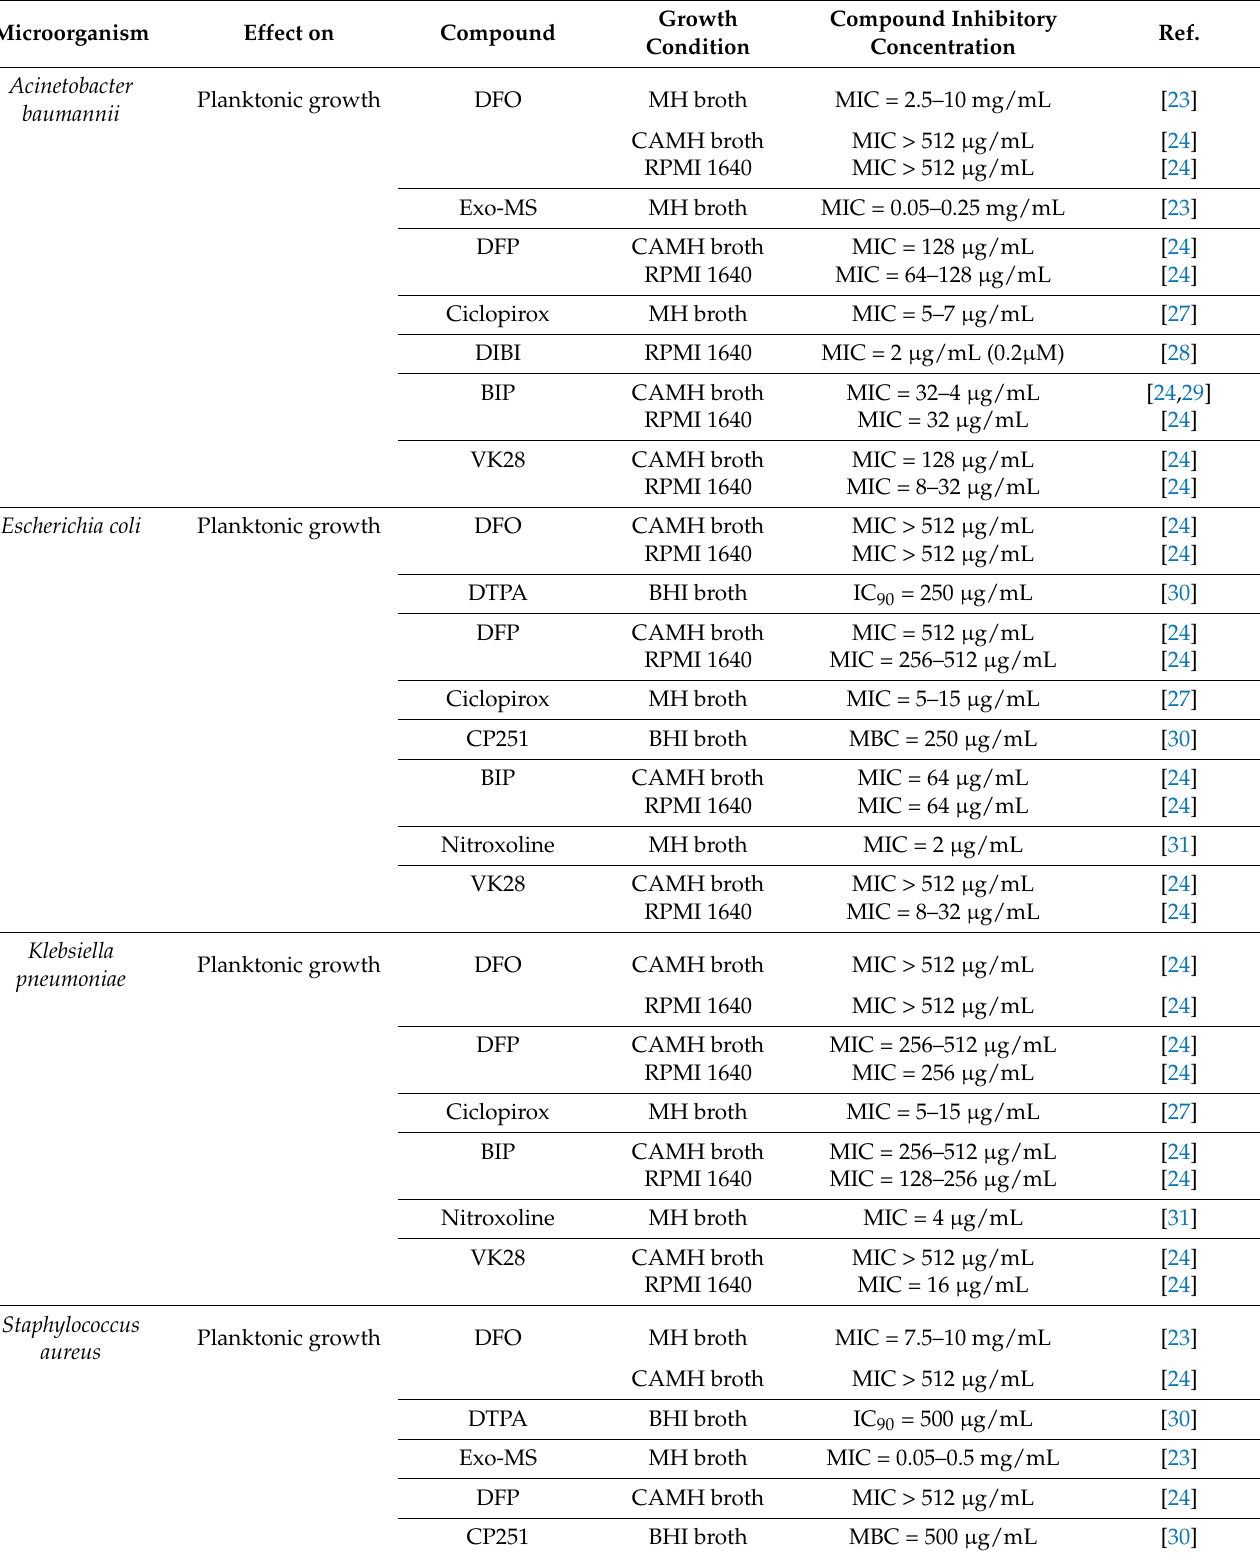
Table 1. In vitro antimicrobial activity of iron